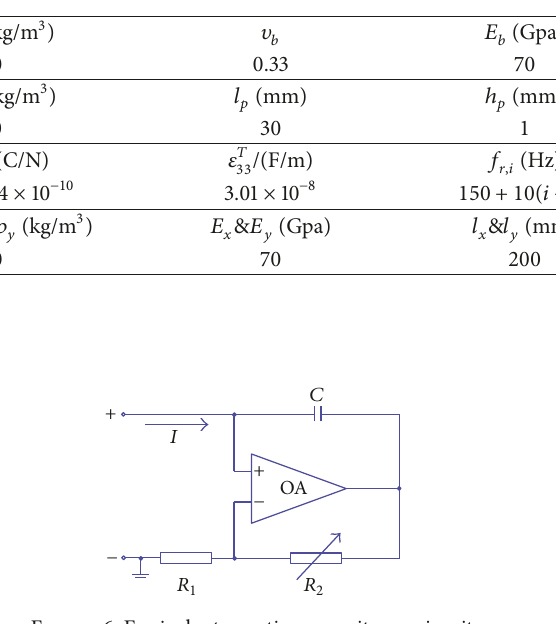
Table 1: Properties of one periodic element.